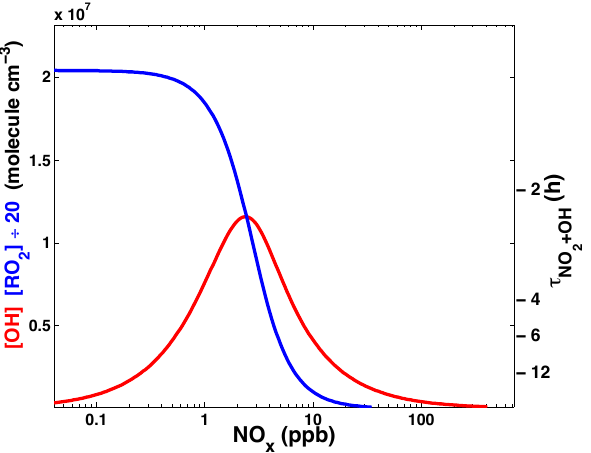
Figure 1. The steady-state relationship of OH (red) and RO 2 (÷20; blue) concentrations to the concentration NO x using the relationship derived in Murphy et al. (2007) under conditions typical of a polluted summertime urban environment. The lifetime of NO x with respect to reaction of NO 2 with OH is indicated on the right axis.